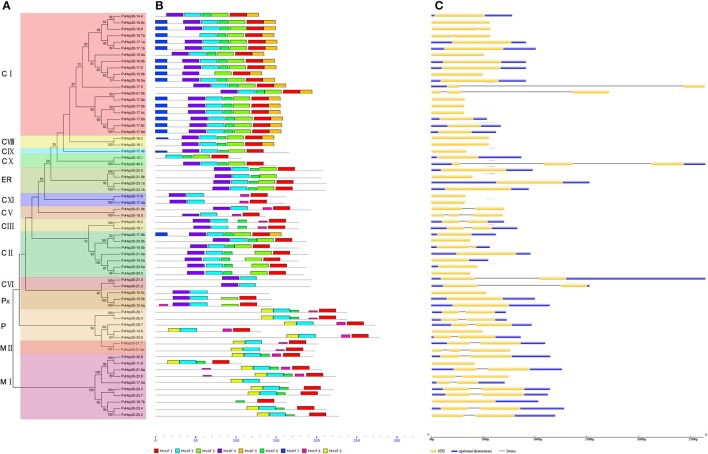
The phylogenetic relationships, motif compositions, and gene structure for sHsp proteins in switchgrass. (A) The alignments of 63 PvHsp20 proteins were conducted by ClustalX, and the phylogenetic tree was built by using MEGA 5.0 based on Neighbor-joining method with 1000 bootstrap replicates and p-distance method. The percentage bootstrap scores above 50% were shown in this tree. 14 phylogenetic sub-clusters were divided according to Figure 1 with different color backgrounds. (B) Schematic representation of the conserved motifs in sHsp proteins was displayed by MEME. Each motif is represented by a type of colored box, while the black lines indicate the non-conserved sequences. (C) Exon/intron organizations of sHsps. Exons and introns are yellow boxes and black lines, respectively, and upstream/downstream sequences are blue boxes.